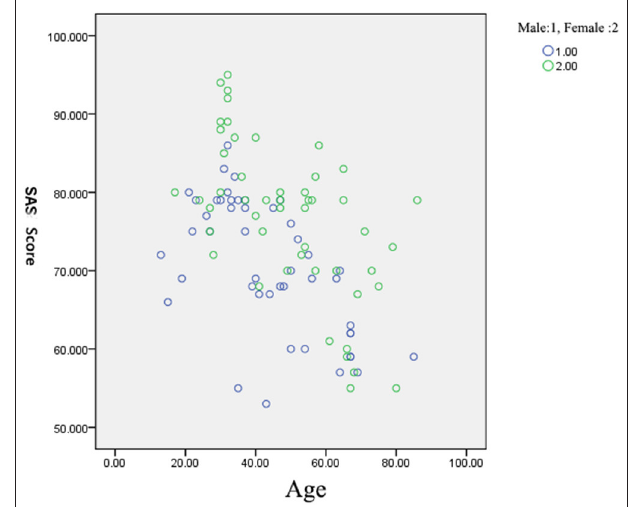
FIGURE 1 | Impact of gender on SAS